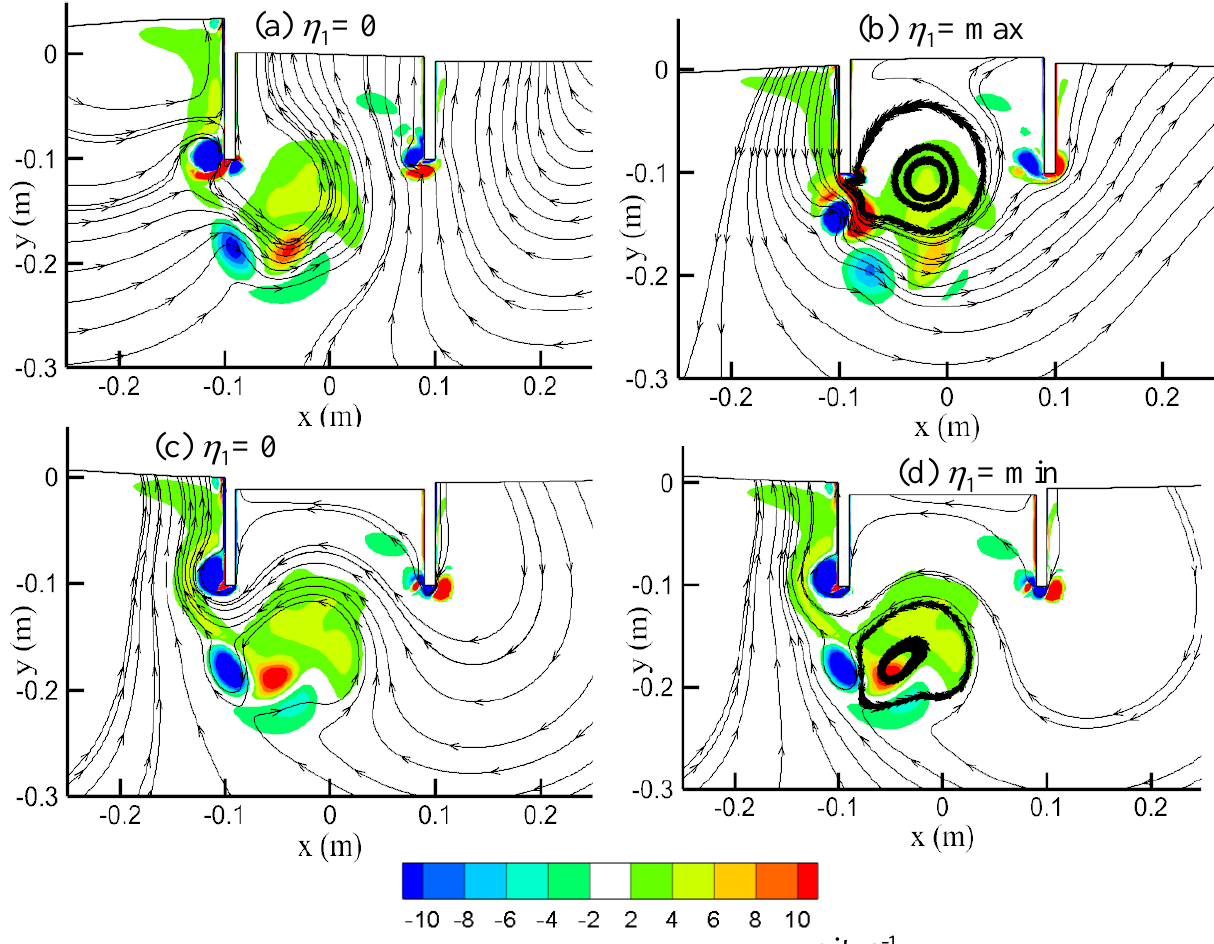
Figure 10. Flow near the OWC represented by streamlines and vorticity contours at vertical motion, m = 2, B/L = 0.159.